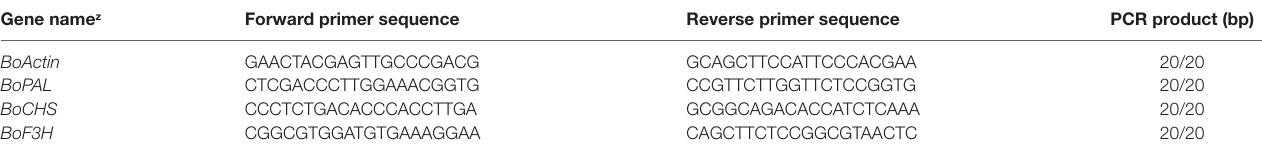
TABLE 1 | List of oligonucleotide primers used for quantitative-real-time